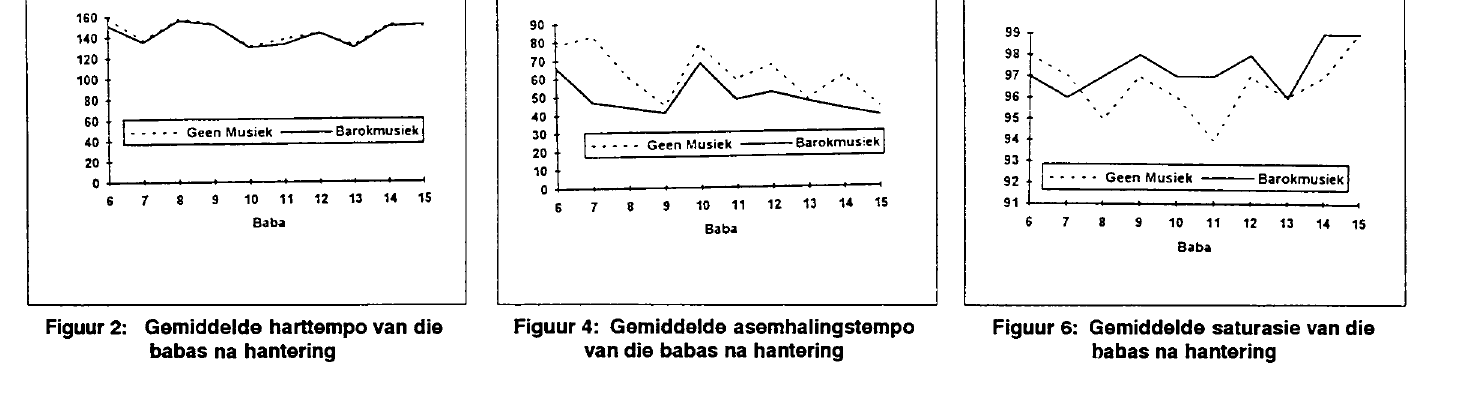
Figuur 6: Gemiddelde saturasie van die babas na bantering